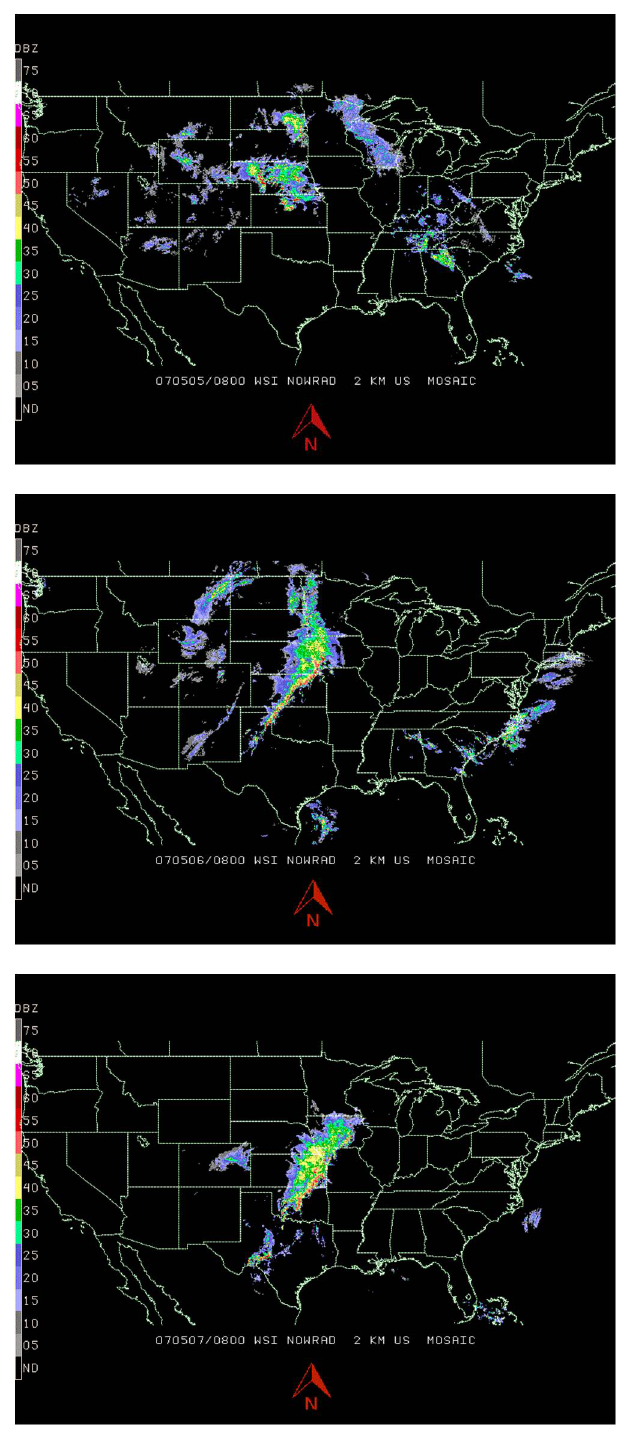
Figure 5. Rain storms in Midwestern US, as captured by NEXRAD radars during the period between 5 May ( top ), 6 May ( middle ) and 7 May ( bottom ), 2007.